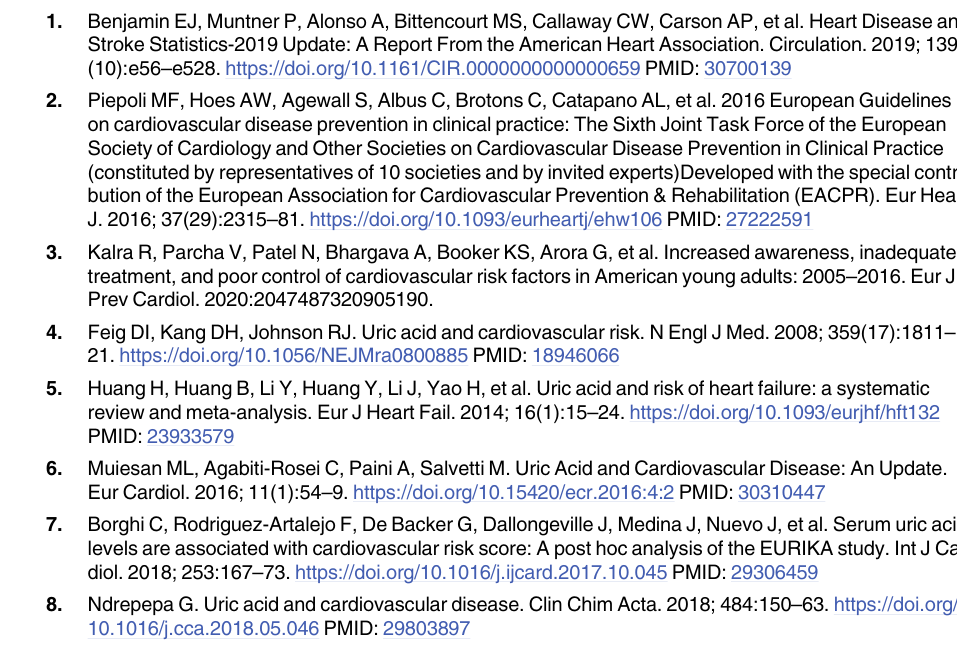
S1 Table. Multivariable associations of SUA with cardiovascular risk factors in U.S.